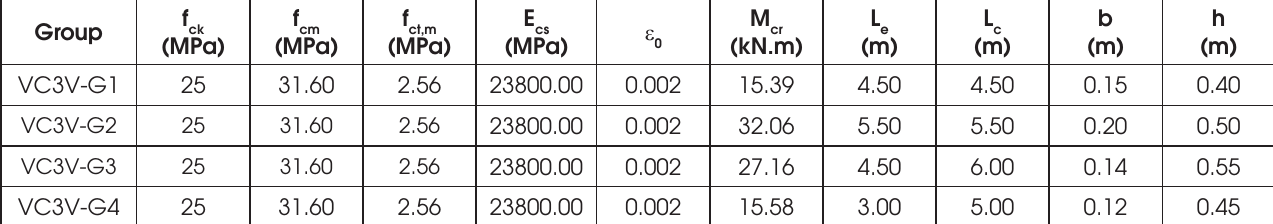
Concrete properties, cracking moment and geometry for the groups of three-span